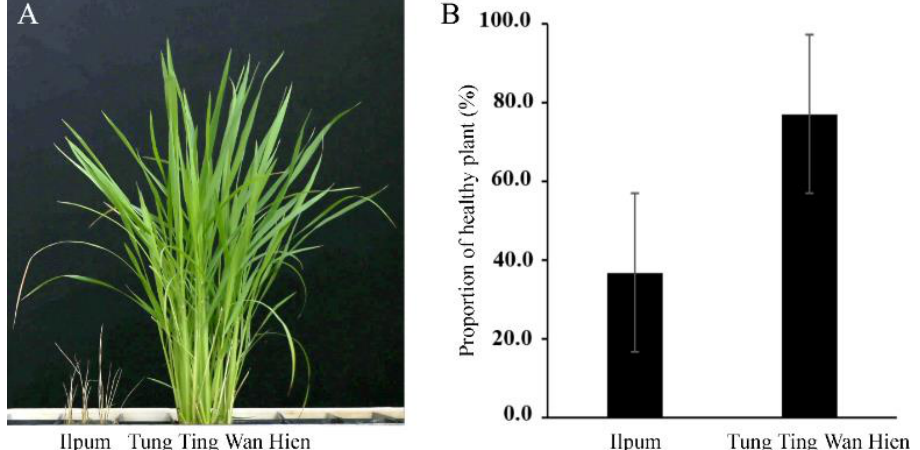
Figure 1. Visual observation of parental phenotypic response towards bakanae disease. ( A ) Distinc- tive phenotypes of parents and ( B ) proportion of healthy plants between parents infected with the Fusarium fujikuroi isolate CF283.